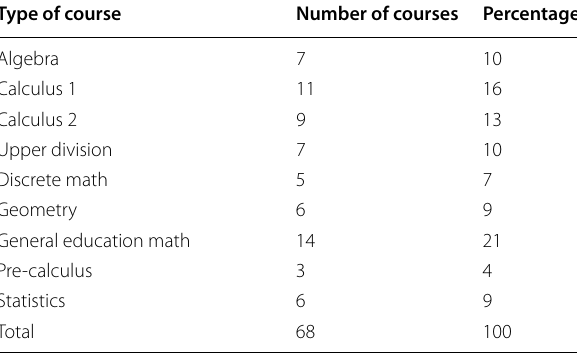
Table 3 Types of